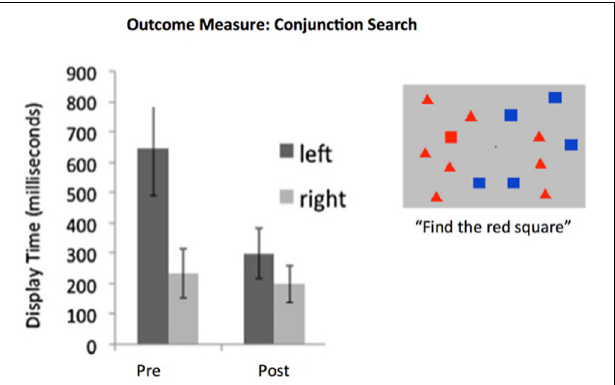
FIGURE 2 | Hemispatial neglect syndrome patients are slow to identify target stimuli arising in the neglected visual hemifield. Training designed to recover the functionality of intrincsic alertness over a period of 6h was adequate for achieving recovery when examined within 48h post-training. Data from 20 neglect patients with a wide panoply of brain-injury etiologies. (e.g., tumor, stroke, TBI). Display time significantly shortened following training. Note that this is a “transfer” effect, as training involving the identification of objects, scenes, or tones was presented at central fixation (i.e., not in the neglected field). Redrawn from DeGutis and Van Vleet (2010) and Van Vleet and DeGutis